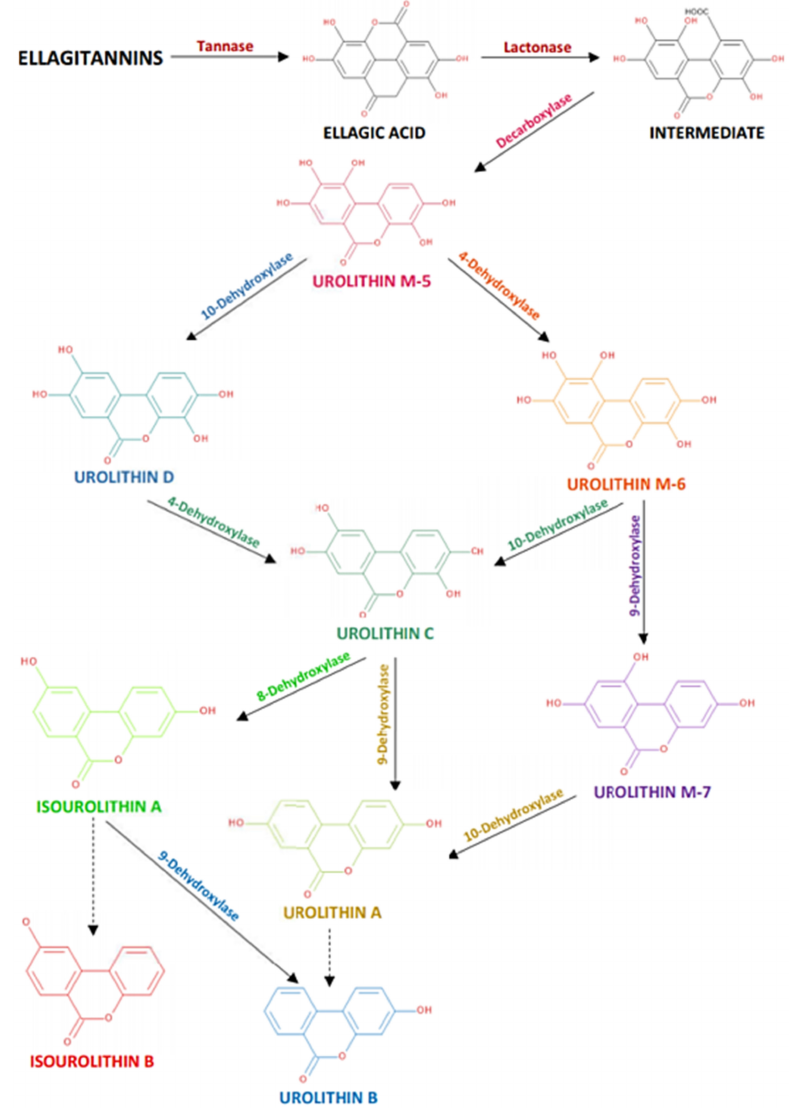
Figure 6. The effect of different dehydroxylases on the microbial biotransformation of ellagitannins to urolithins as adapted with light modification by the study of Sallam et al. [123], which originated from the study of Epsin et al. [118]. Reprinted from ref.